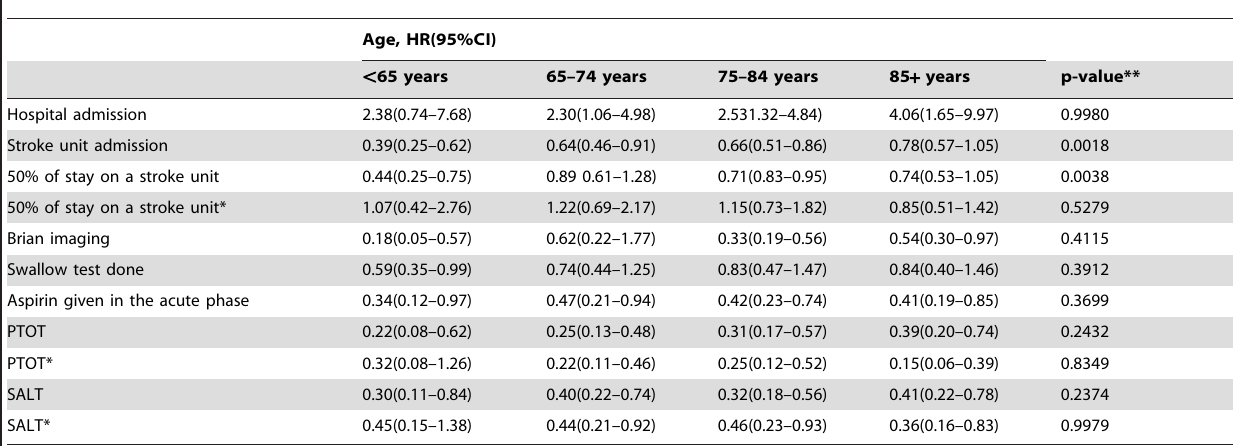
Table 2. Relative hazard of death following receipt of acute care interventions by age group.